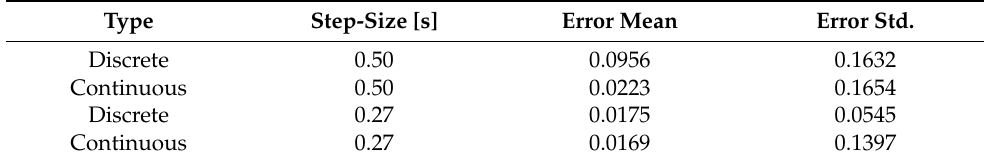
Table 2. Error distribution of discrete D.A.I. and continuous D.A.I. at varying step-sizes.